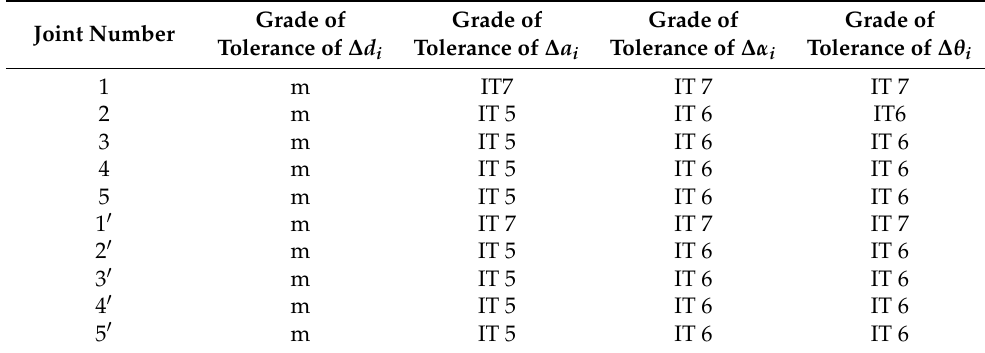
Table 2. Manufacturing tolerance grade